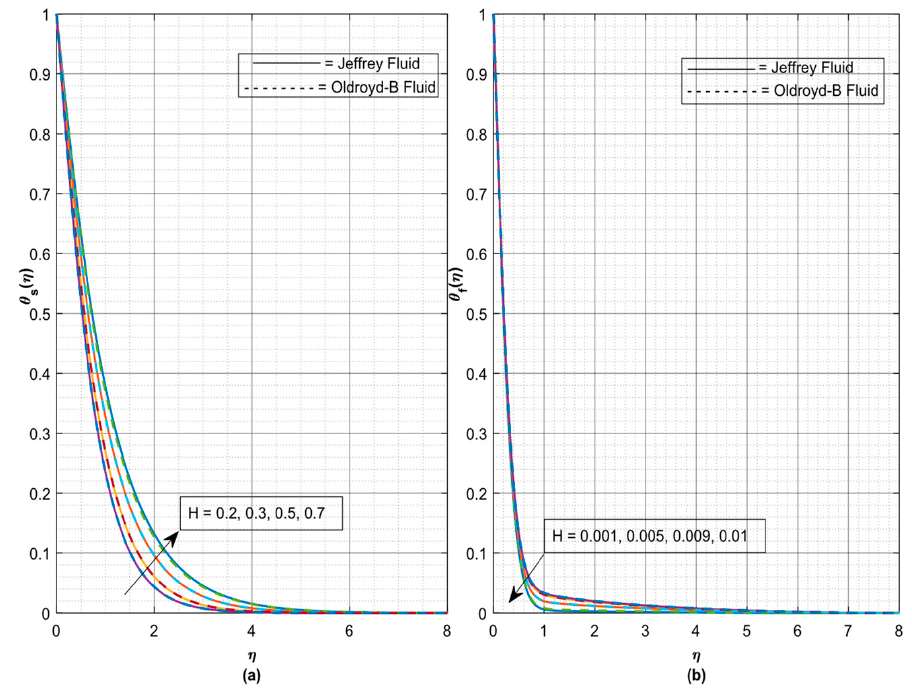
( ) θ η , and ( b ) effect of H on f